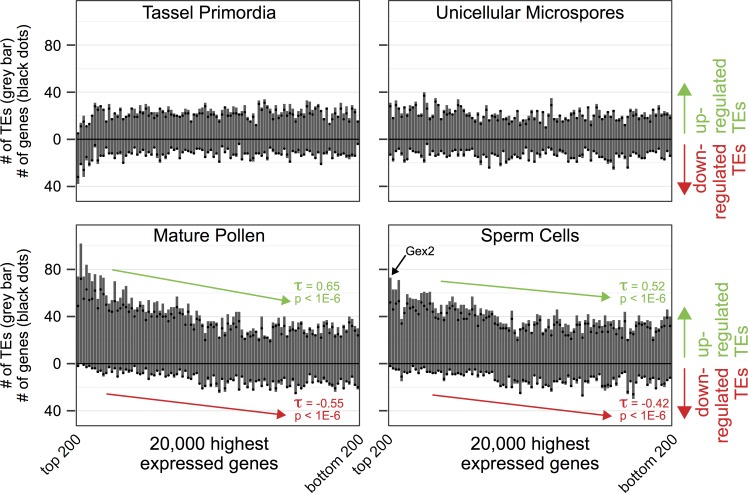
Co-regulation of TE and gene expression in the male gametophyte.For each tissue type, the top 20,000 most highly expressed genes are distributed along the X-axis in bins of 200, with the most highly expressed bin on the far left. For each bin the number of up- and down-regulated TEs near (<2kb) that bin’s genes is then summed on the Y-axis (shown in grey bar). For each bin, the number of genes with at least 1 up- or down-regulated TE within 2kb is displayed as black dots. In unicellular microspores (top right) there is little correlation, whereas in mature pollen and sperm cells (bottom panels) the most highly expressed genes are near primarily up-regulated TEs. To check if the perceived correlations are statistically significant, we performed Kendall’s Tau rank correlation tests and found significant correlations (p < 1E-6) only for mature pollen and sperm cells for both number of TEs and number of genes. For mature pollen, gene expression has a positive correlation with up-regulated TEs (#TEs: τ = 0.65, #genes: τ = 0.64) and a negative correlation with down-regulated TEs (#TEs: τ = -0.55, #genes: τ = -0.55). Similarly for sperm cells, gene expression has a positive correlation with up-regulated TEs (#TEs: τ = 0.52, #genes: τ = 0.52) and a negative correlation with down-regulated TEs (#TEs: τ = -0.42, #genes: τ = -0.44). Only TE (not genes) rank correlation coefficients (τ) are displayed in the figure. The bin location of gex2 (see Fig 7) is annotated in the sperm cell data.